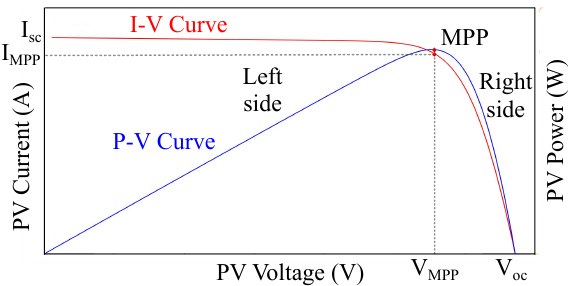
Figure 5. I-V and P-V characteristics on both